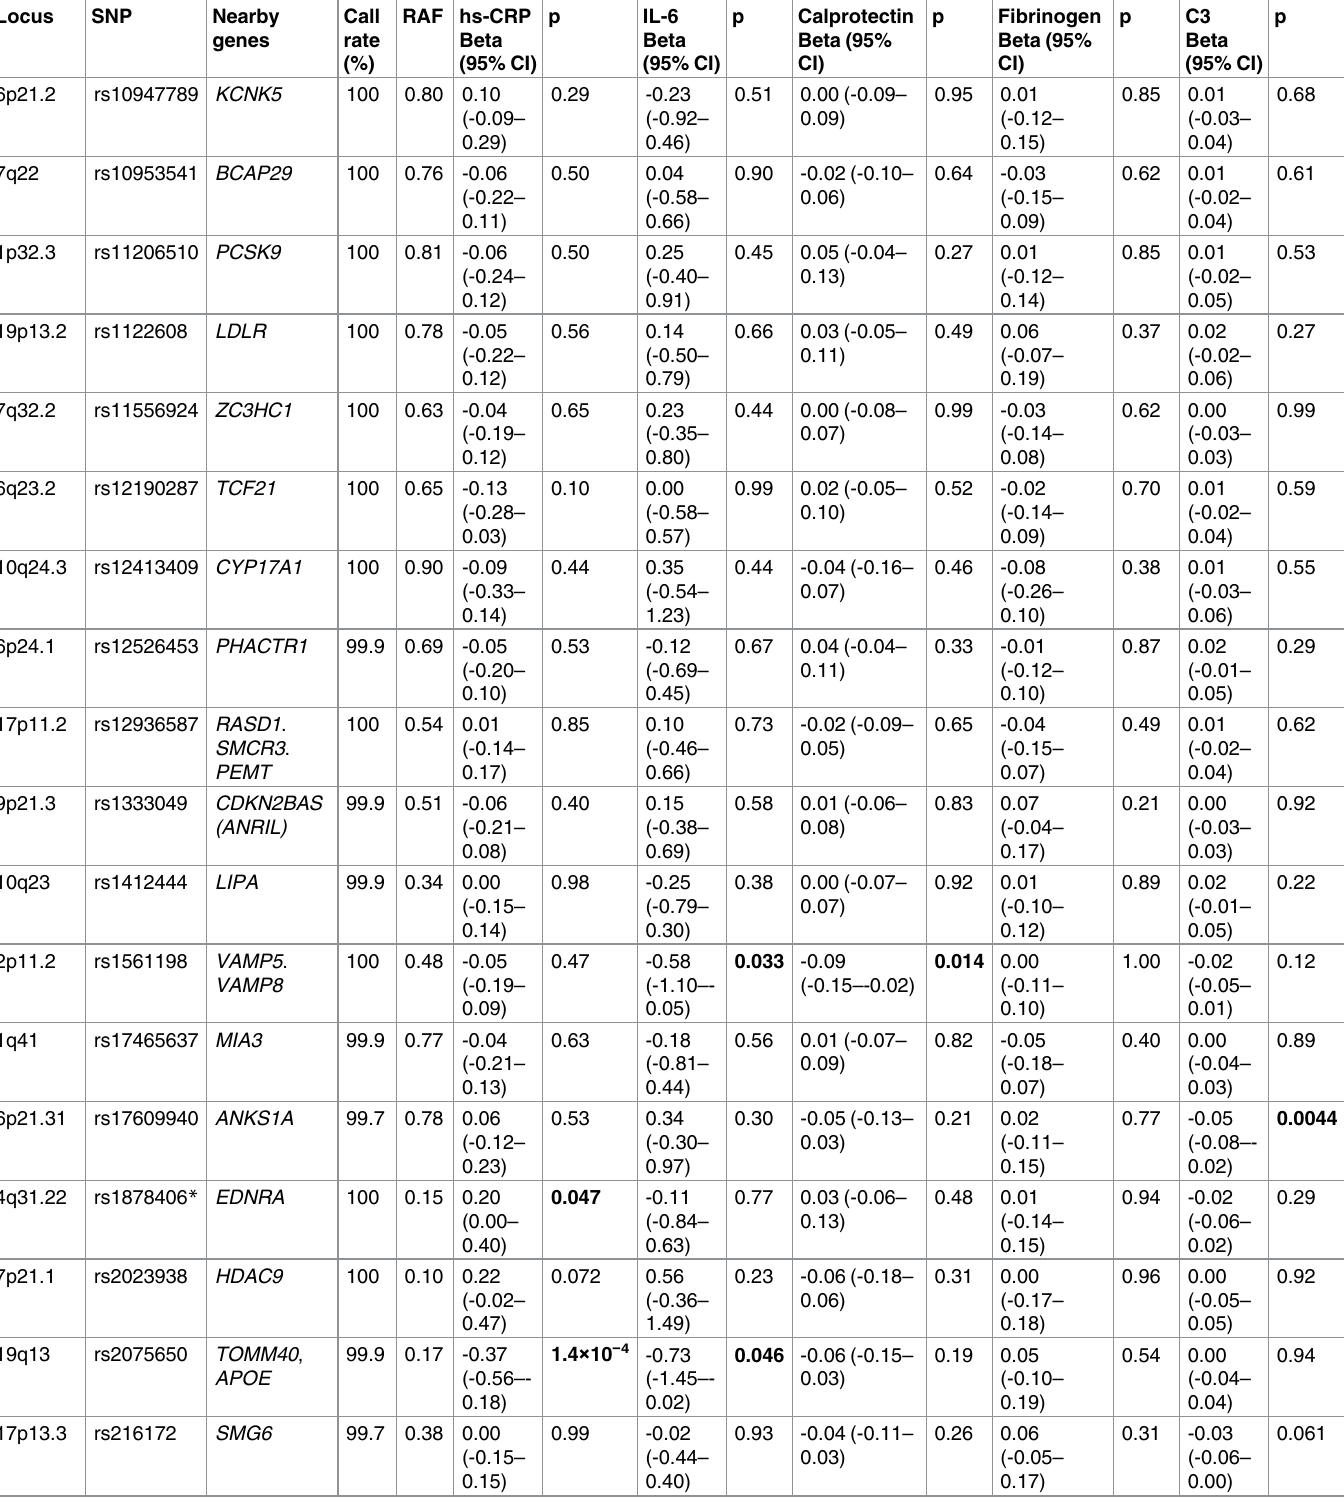
Table 3. Associations between remaining CAD-related SNPs and inflammatory proteins.